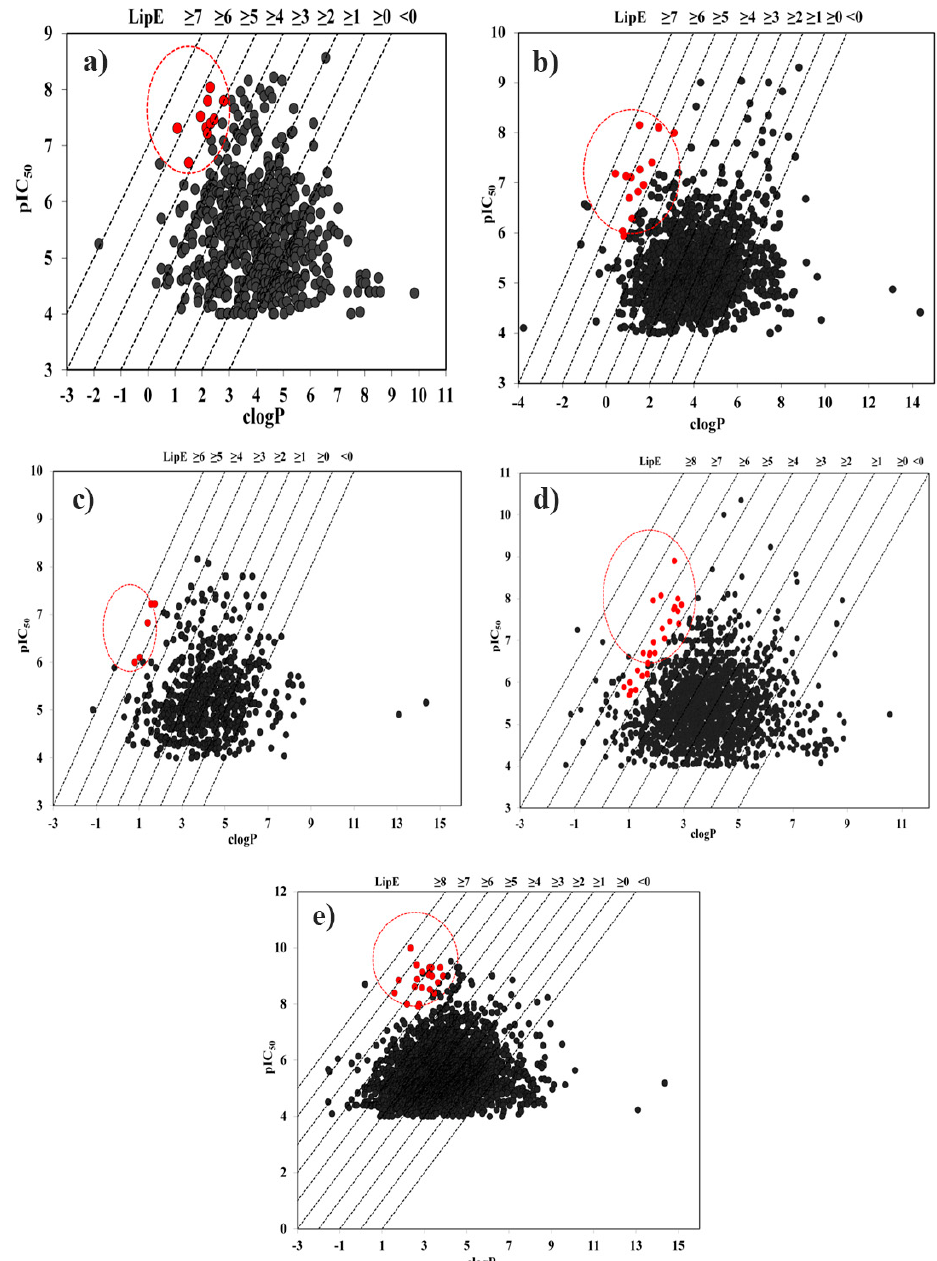
Figure 4. LipE profiling of ( a ) CYP1A2, ( b ) CYP2C9, ( c ) CYP2C19, ( d ) CYP2D6 and ( e ) CYP3A4 inhibitors, where clogP is plotted against the activity (pIC 50 ). The cytochrome P450 inhibitors fulfilling Leeson and Springthorpe criteria (LipE of ~5–7) and clogP ~1–3 are highlighted (red color) in the plot for each CYP isoform.